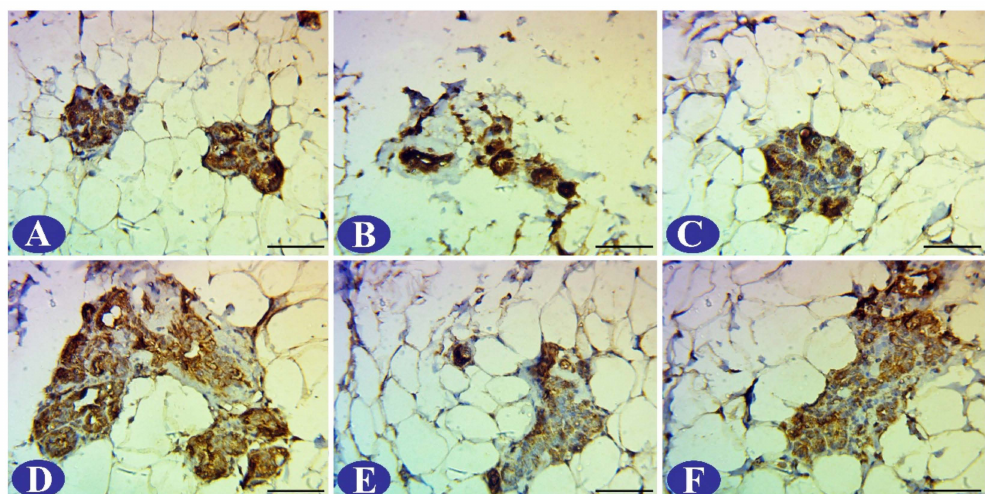
Figure 5. Results of Immunohistochemical Assessment of Bcl2. ( A ) Breast tissue of negative control group showed over-expression of Bcl2. The ( B ) 7b group showed increased acinar Bcl2 expression. ( C ) 15b group showed marked Bcl2 expression in the lobular tissue. ( D ) Breast tissue of DMBA-dosed rats revealed over-expression of Bcl2 in the tumor mass. ( E ) Breast tissue of DMBA dosed rats treated with 7b revealed faint Bcl2 expression. ( F ) Moderate Bcl2 expression was detected in the DMBA group treated with 15b . Scale bar = 50 µ m.